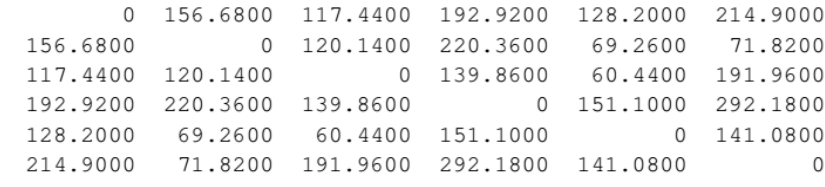
Figure 3. Adjacency Matrix [ δ ( A i , A j )] 6